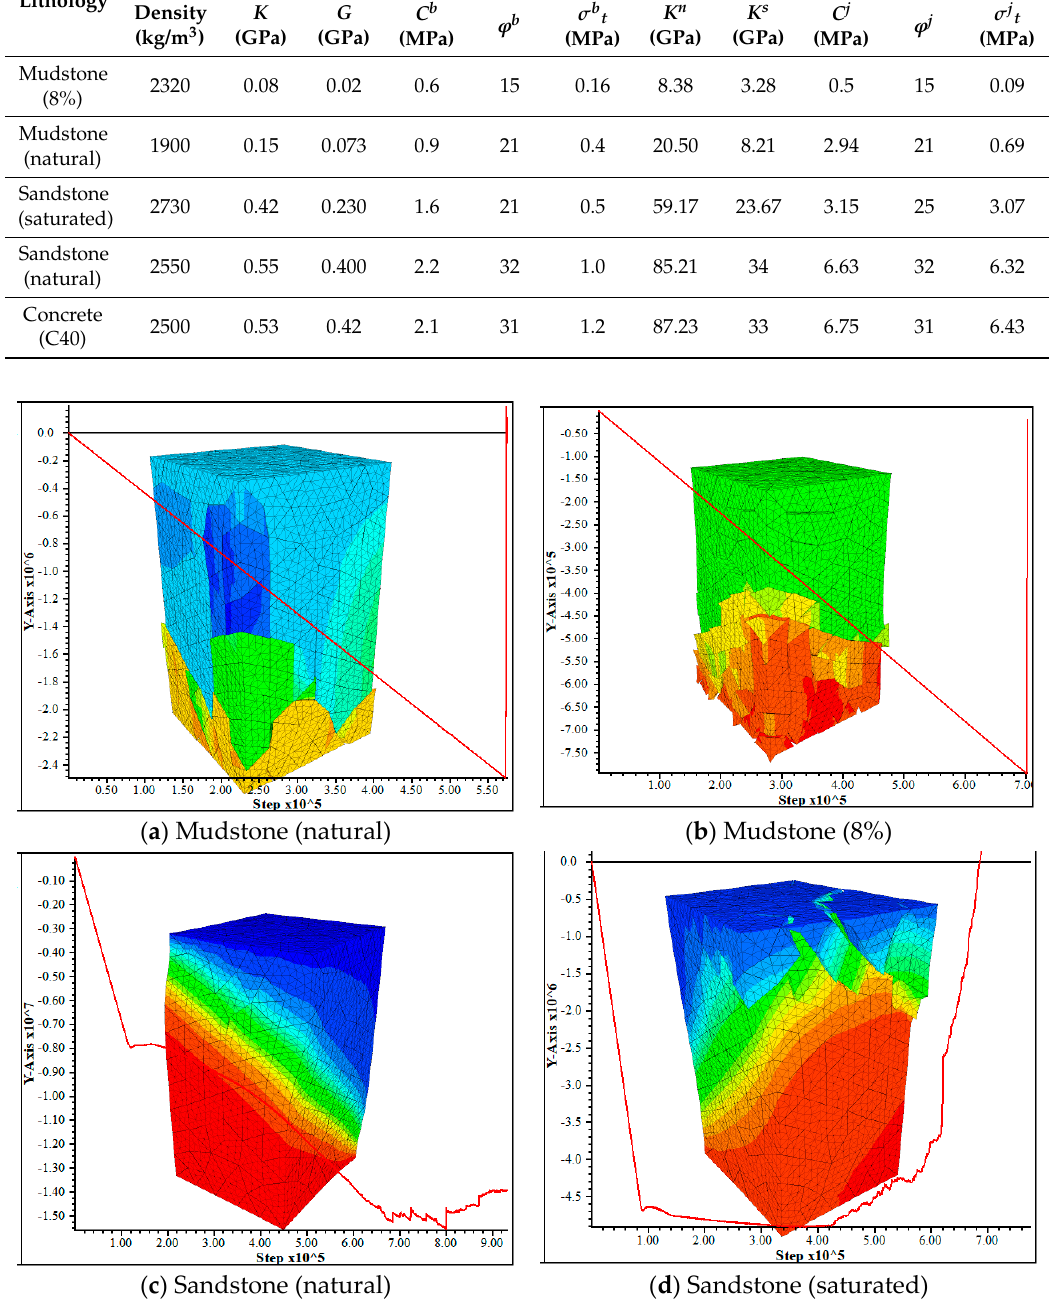
Figure 7. Simulated uniaxial compressive test for the rock mass.